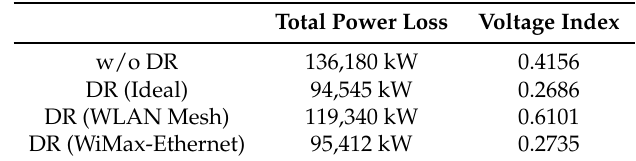
Table 3. The power loss and the voltage of 34 Node system.